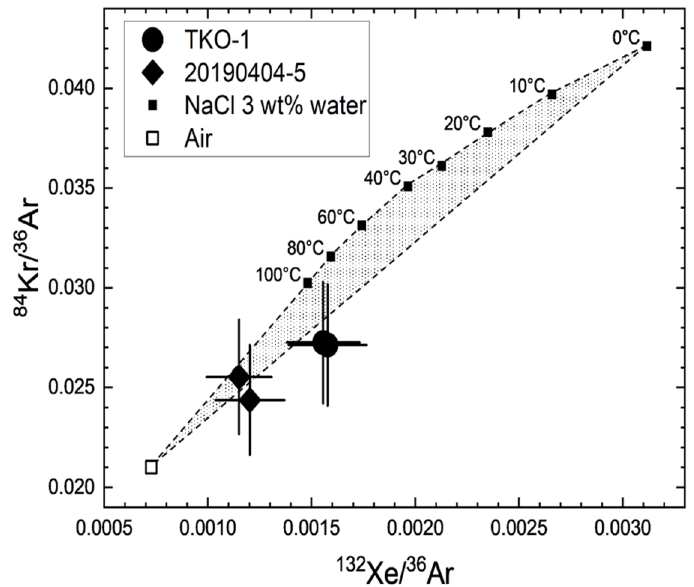
Figure 5. Plot of 84 Kr/ 36 Ar against 132 Xe/ 36 Ar obtained with crushing extraction. End-member compositions of air and air-saturated salt water (3.0 wt% NaCl equivalent) with temperatures ranging from 0 to 100 ° C (calculated after Ballentine et al. (2002) [36]) are also plotted. A shaded area indicates a mixing between heavy noble gases dissolved in the salt water and unfractionated excess air. Error bars are 1 sigma.